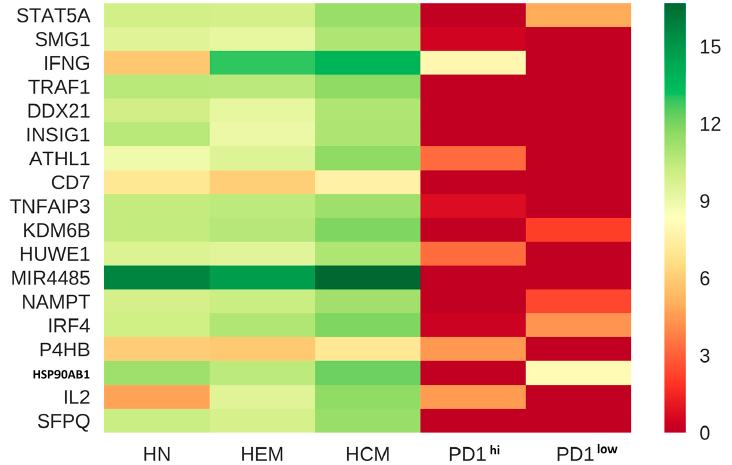
Figure 4. A heatmap generated using significantly modulated genes ( p < 0.01) across the T cells of healthy people and tumor infiltrating CD8 T cells. HN, HEM and HCM represent human Naïve T cell, human effector T cell, and human memory T cell, respectively from healthy people, while PD1 hi and PD1 lo represent the tumor-infiltrating CD8 T cells with high- and low-expression of PD1, respectively. The rows are modulated genes, and colors represent the gene expression levels. The darker shade of red indicates a low-expressed pattern, while a green shade depicts a high-expressed